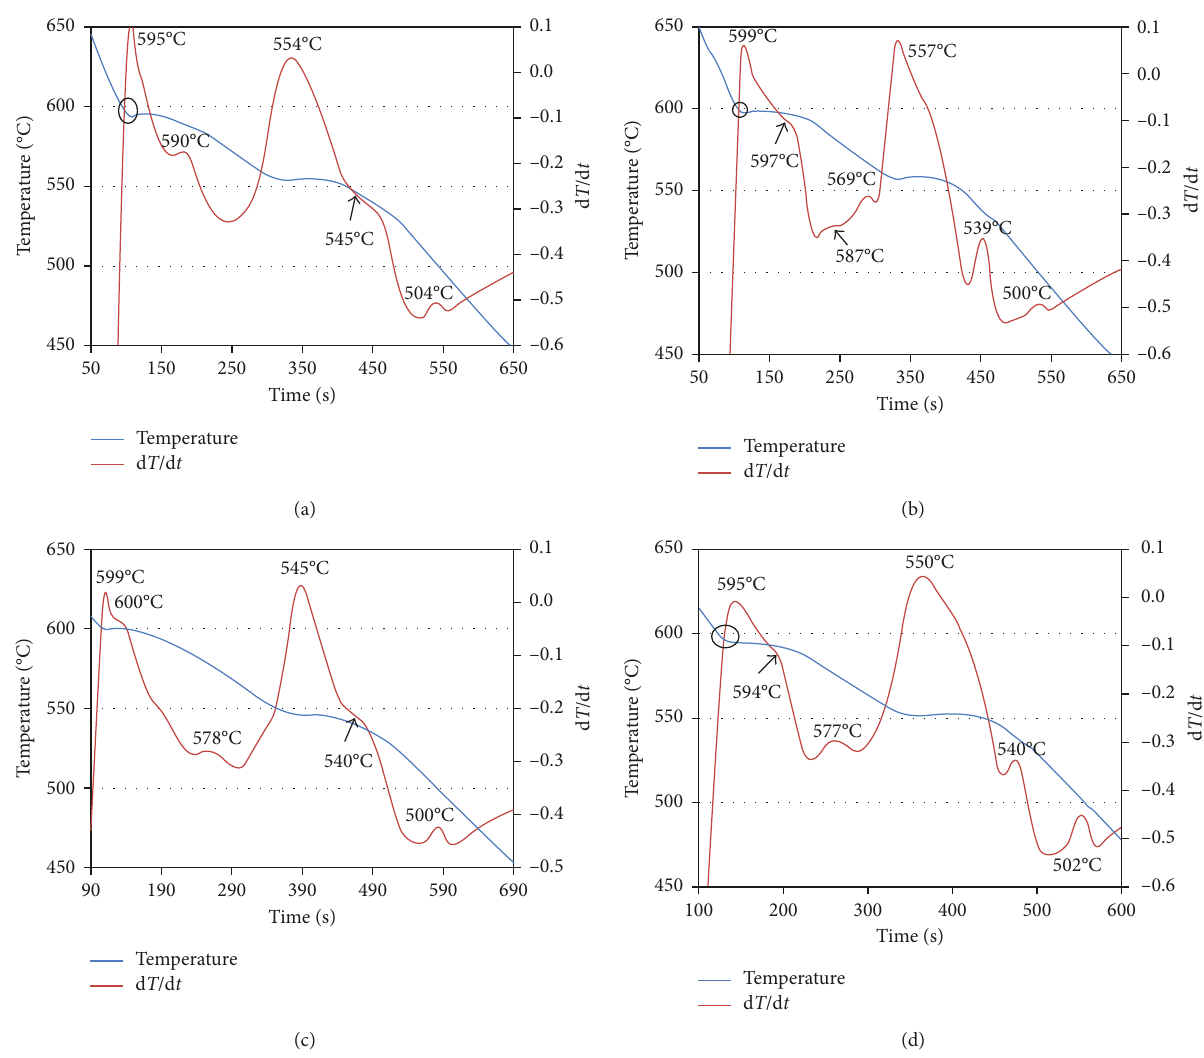
Figure 4: Temperature-time curves and their first derivatives obtained from the D0 alloy series: (a) D0+Ce; (b) D0+ Ce+Ti; (c) D0 +La; (d) D0+La